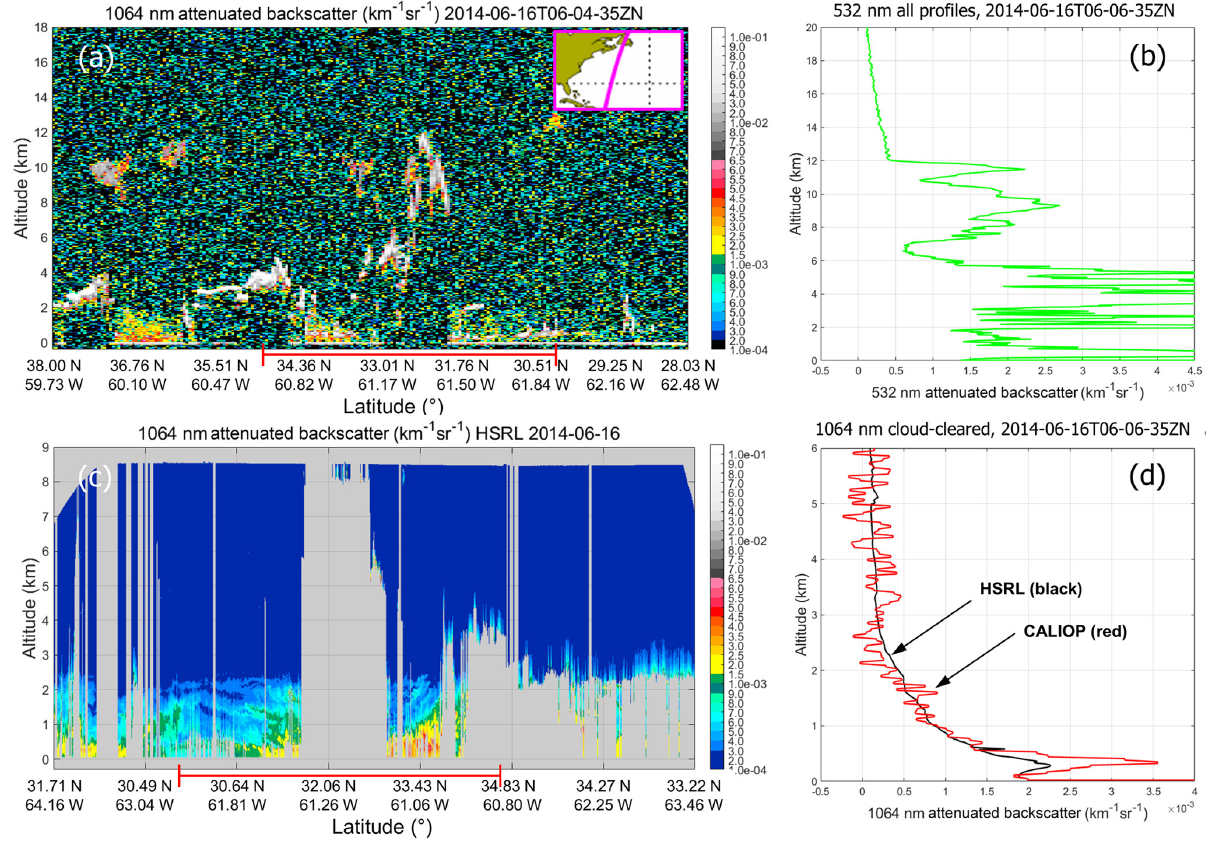
Figure 29. Nighttime CALIOP and HSRL measurements acquired 16 June 2014 over the Atlantic Ocean in the vicinity of Bermuda. The CALIOP profiles in panel (a) are averaged to a 5km horizontal resolution (15 laser pulses acquired over ∼ 0 . 75s). The HSRL profiles shown in panel (c) are averaged to a temporal resolution of 10s. The red lines at the bottom of panels (a) and (c) indicate coincident portions of the two data sets. Panel (b) shows the average of all CALIOP 532nm attenuated backscatter coefficient profiles acquired during full validation flight segment while panel (d) shows the average of the CALIOP 1064nm attenuated backscatter coefficient profiles that were classified as being cloud free (386 of 1500).